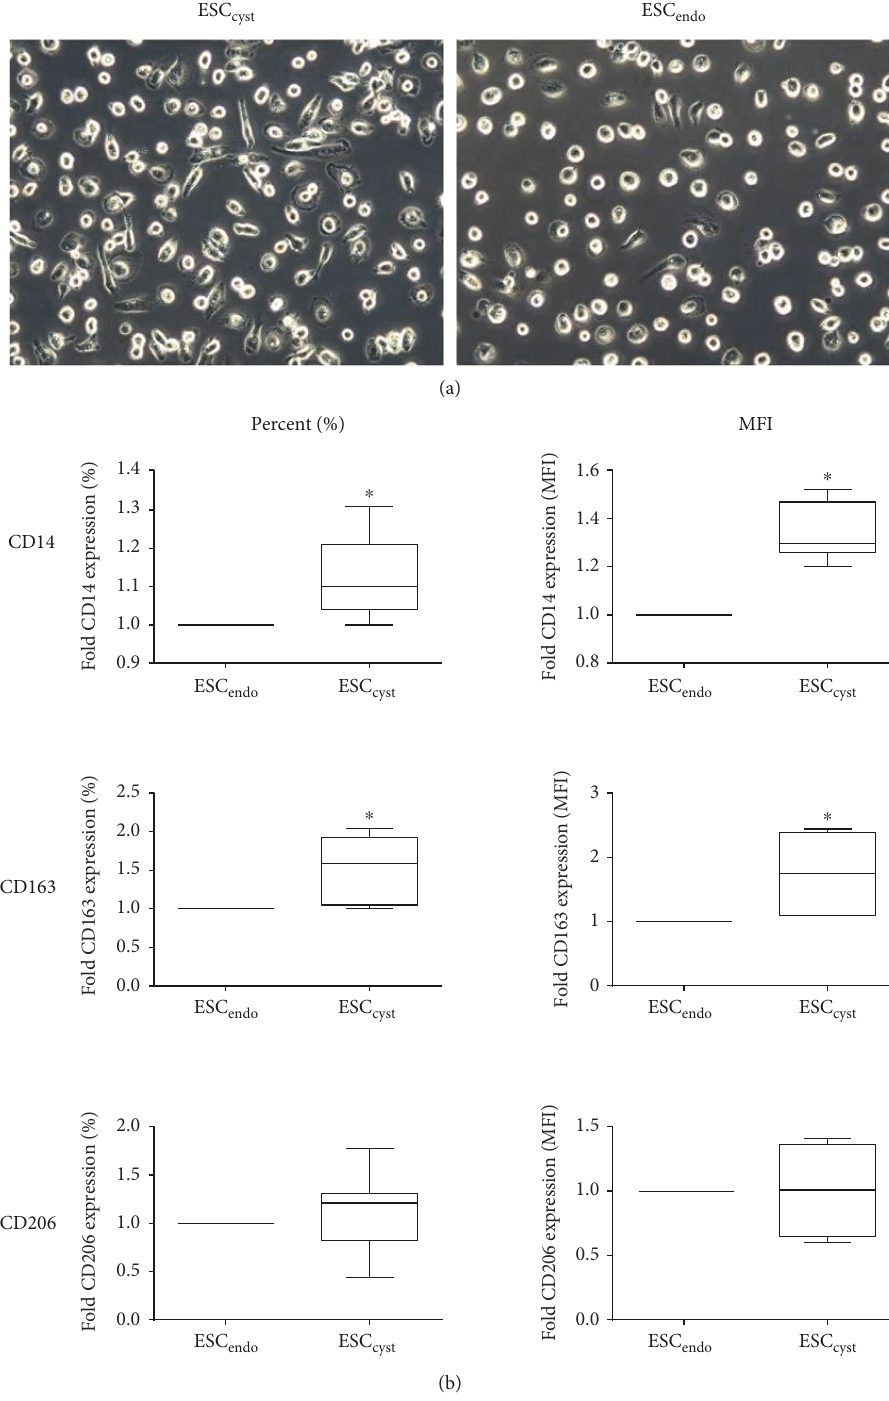
Figure 4: The e ff ects of ESC and ESC conditioned medium (CM) on freshly isolated untouched human monocytes. Representative endo cyst phase contrast images (a) of the CM-treated monocytes after 7 days of culture at 20x magni fi cation. The percentage of macrophages expressing CD14 and CD163 and the level of expression in these positive macrophages are greater for ESC percentage of macrophages expressing CD206 and the level of expression in these positive macrophages are not di ff erent between ESC and ESC (b). Seven independent experiments ( n = 4 biological replicates) were carried out in duplicates. Mean ± SD. Scale bars cyst represent 50 μ m at 20x magni fi